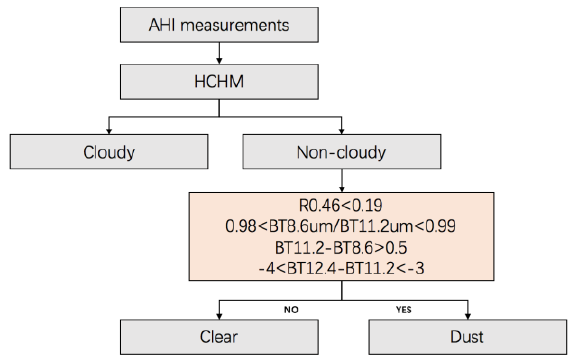
Figure 4 The flowchat of the added tests to detect